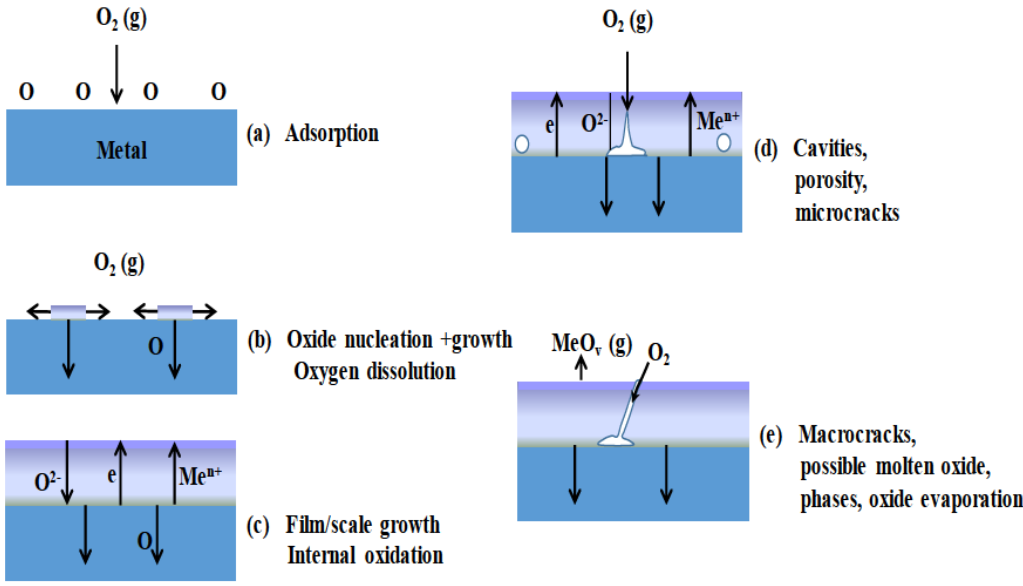
Figure 1: High-temperature metal oxide formation diagram, (a) adsorption of oxygen, (b) diffusion of oxygen, (c) formation of film/scale, (d) growth of film/scale and (e) formation of thick oxide